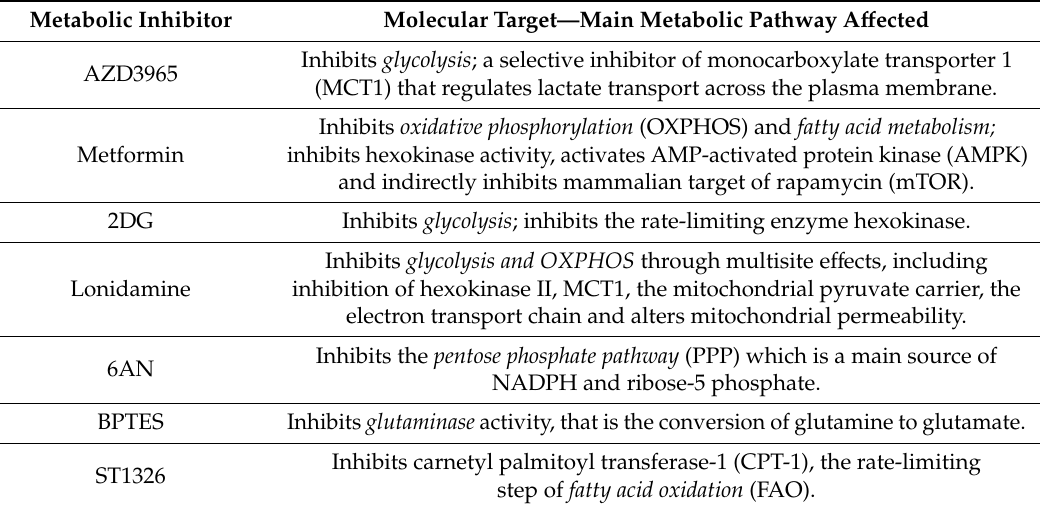
Table 2. Main targets and metabolic e ff ects of the seven metabolic inhibitors tested on AML cells in this study. (For more detailed information and references, see Table